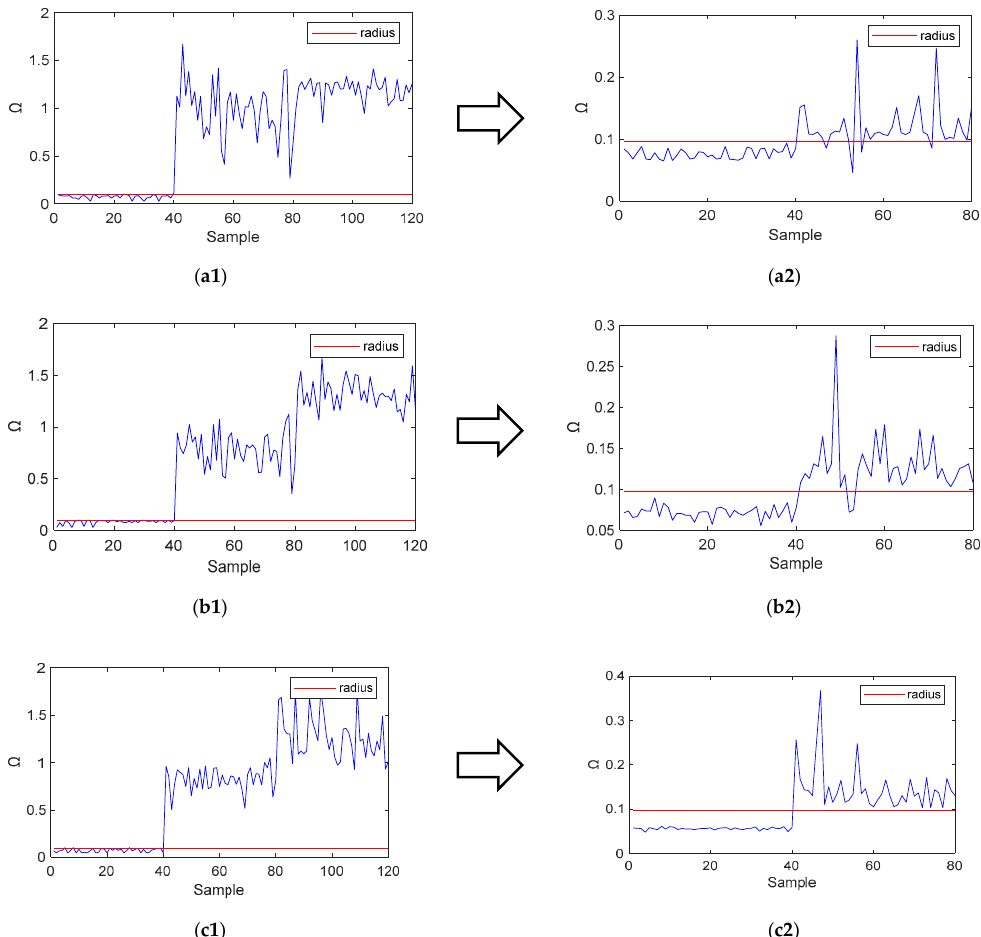
Figure 8. The results of the KPCA-Cas-SVDD method for pipeline leak detection. ( a1 ) KPCA-Cas- Figure8. TheresultsoftheKPCA-Cas-SVDDmethodforpipelineleakdetection. ( a1 )KPCA-Cas-SVDD 1